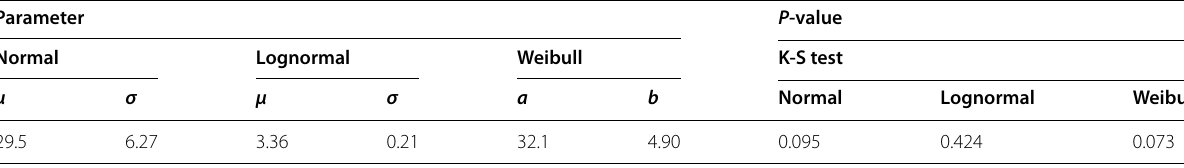
μ : mean, σ : standard deviation, a : scale parameter, b : shape